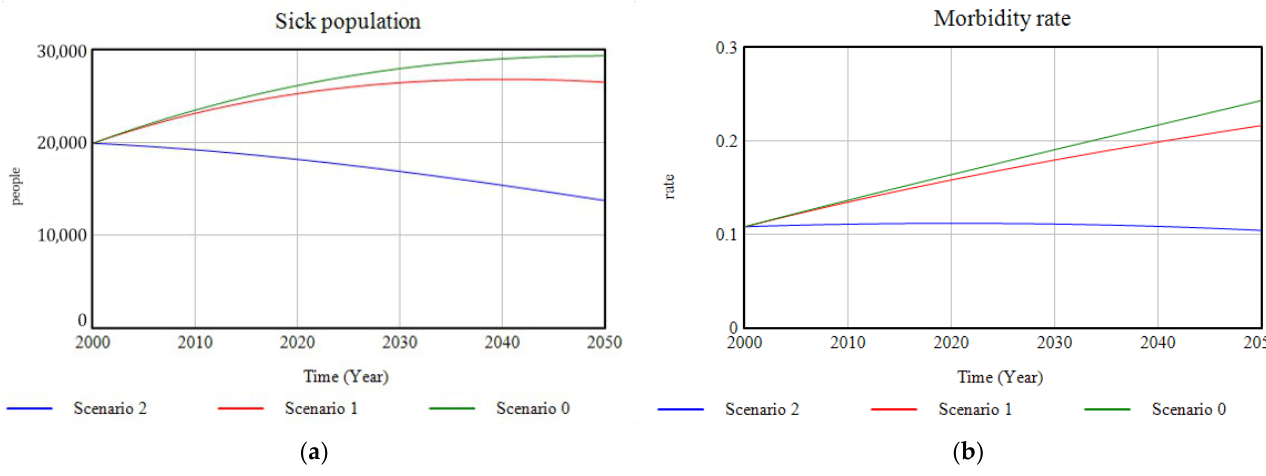
Figure 17. ( a ) Graphic representation of the evolution of sick population; ( b ) graphic results of the evolution of the morbidity rate for the three cases of study, in the period 2000–2050.